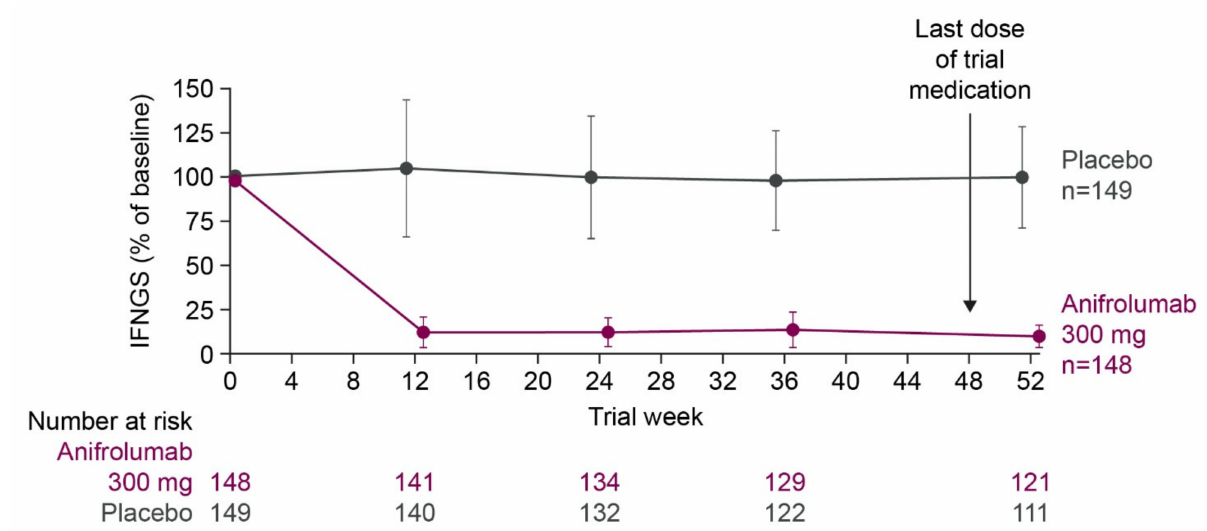
Figure 6. Median percentage of baseline IFNGS score throughout the treatment period in IFNGS-high patients with SLE in a phase 3 trial of anifrolumab versus placebo alongside background standard therapy. IFNGS was measured using the expression of 21 IFN- α / β inducible genes and expressed as a median percentage of baseline score. Error bars represent median absolute deviation. All patients received background therapy with oral glucocorticoids and/or immunosuppressants. Figure reproduced from Morand, E.F. et al. Trial of anifrolumab in active systemic lupus erythematosus. New Engl J Med 2020, 382, (3), 211–221 [50]. 2021 Massachusetts Medical Society. Reprinted with permission from Massachusetts Medical Society. IFN, interferon; IFNGS, interferon gene signature; SLE, systemic lupus erythematosus.